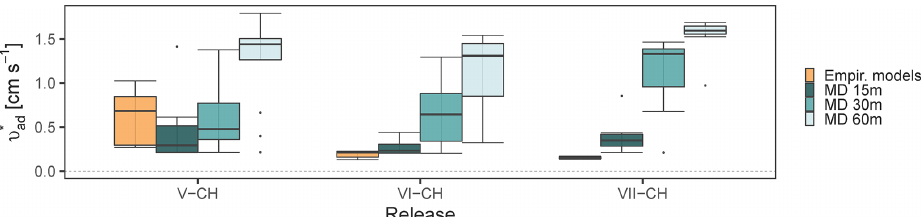
Figure 6. Corresponding apparent surface deposition velocities ( υ ∗ (MD) in release V-CH, VI-CH, and VII-CH and υ ∗